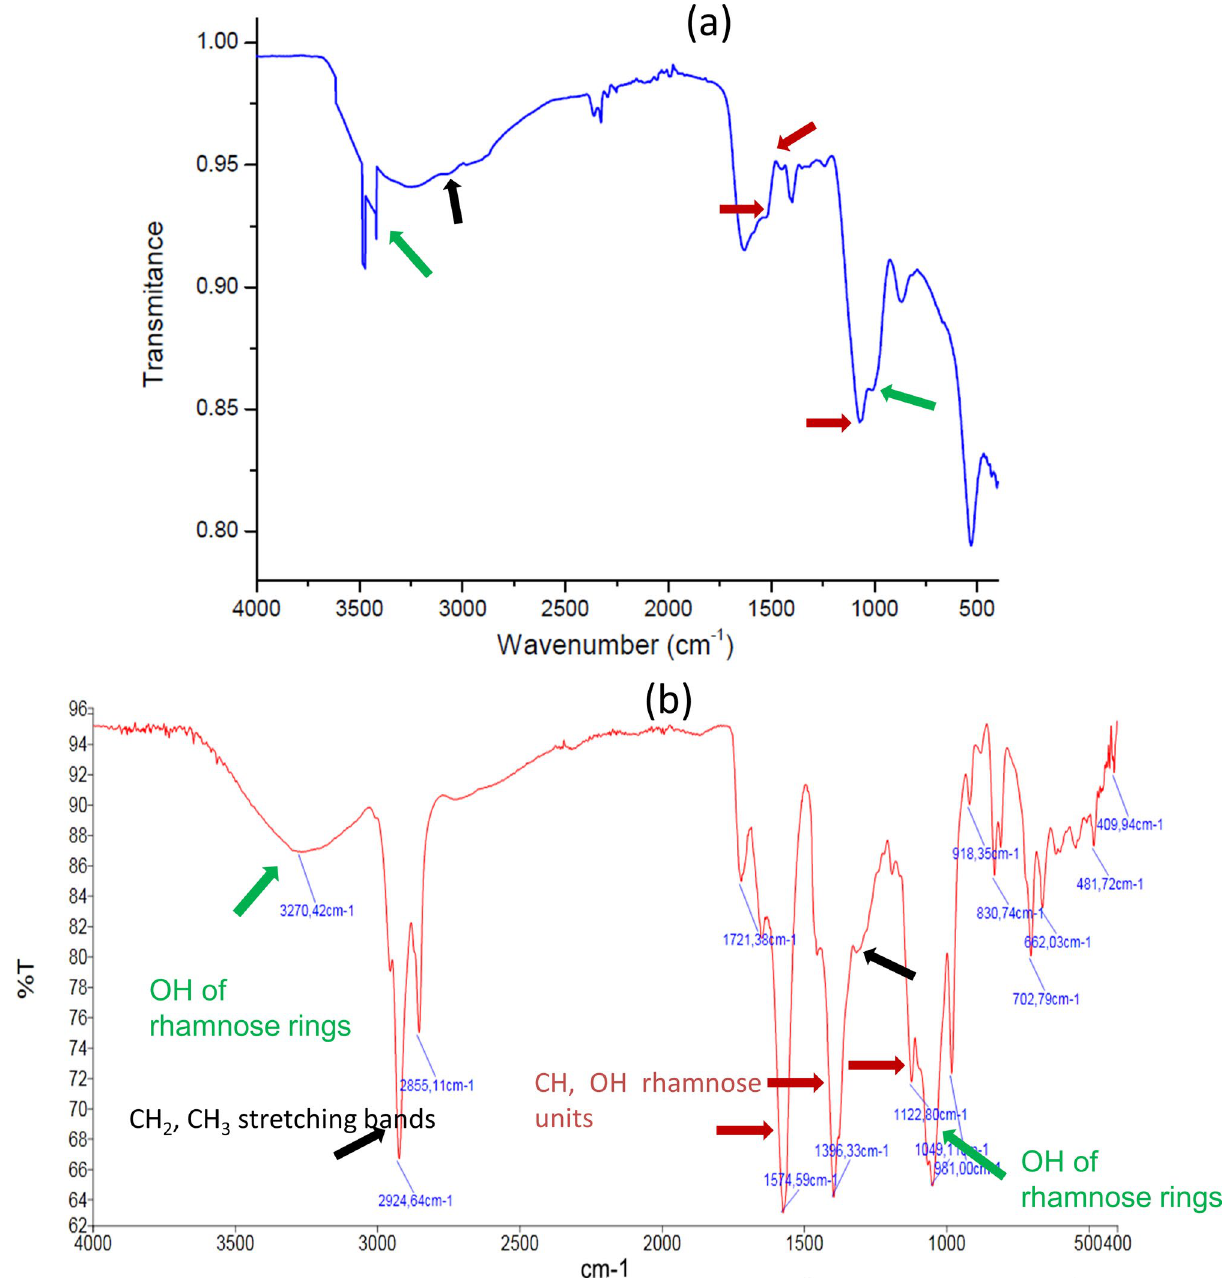
Figure 2. Fourier transform infrared spectroscopy spectra of ( a ) obtained biosurfactant of BUN14 ( b ) a commercial Pseudomonas aeruginosa rhamnolipid BS (R90) (AGAE Technologies, Corvallis, OR, USA) used as a reference